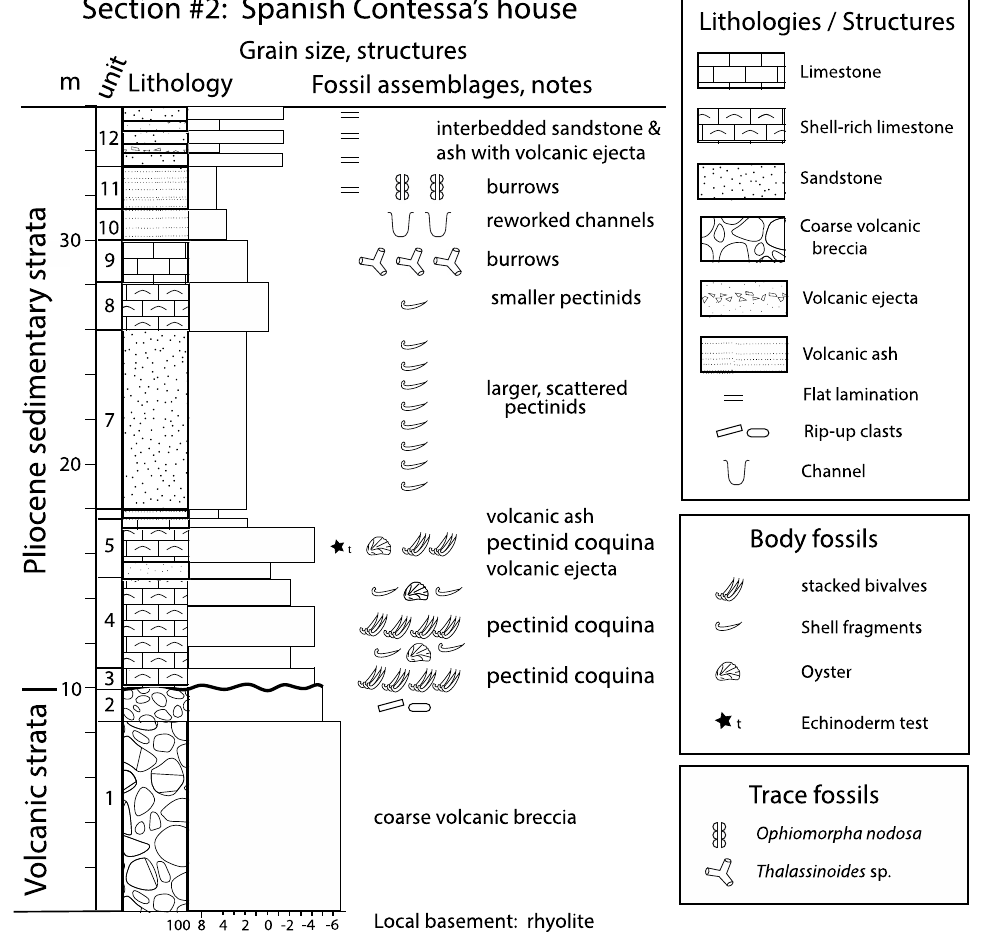
Figure 9. Shore succession immediately south of the Spanish Contessa’s house (26° 22’ 13.40”; 111° 25’ 44.93” W). Note: Variations in sediment size are indicated by the phi scale (8 to − 6).